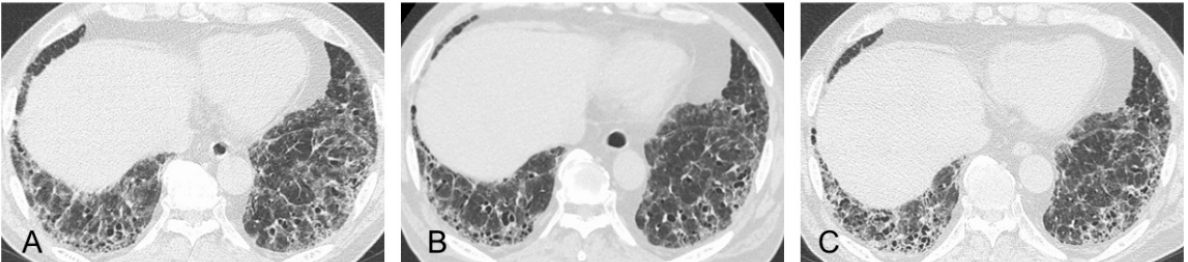
Figure 5. Radiologic course of the same patient with MPO-ANCA-positive ILD shown in Figure 2. ( A ) At the time of transbronchial lung cryobiopsy, high-resolution computed tomographic (HRCT) imaging showed subpleural reticulations with traction bronchiectasis as the framework of UIP and ground-glass opacities (GGOs) to some extent in the bilateral lung field. ( B ) At six months after anti-inflammatory treatments, the findings regarding GGOs were improved. ( C ) At six more months later, HRCT showed a moderate increase in disease extent of the reticulations and traction bronchiectasis as indications of progressive fibrosis, for which therapy with the anti-fibrotic agent nintedanib was initiated.